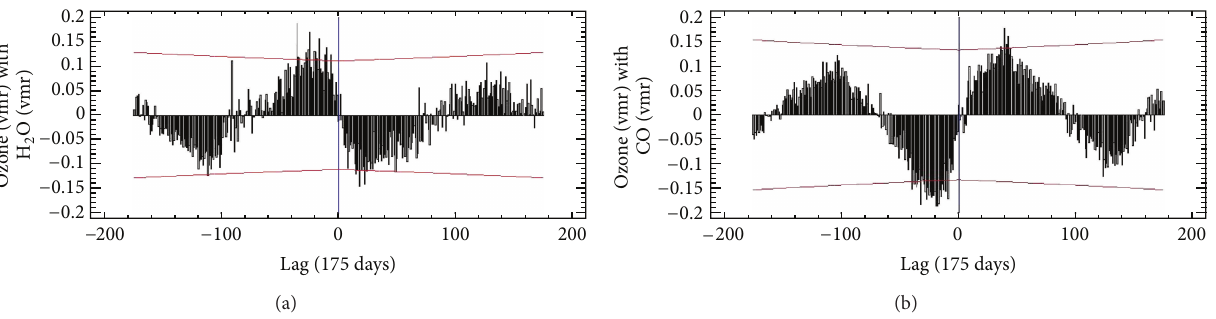
Figure 6: Cross correlation between ozone and (a) water vapor and (b) carbon monoxide for years 2005–2010.